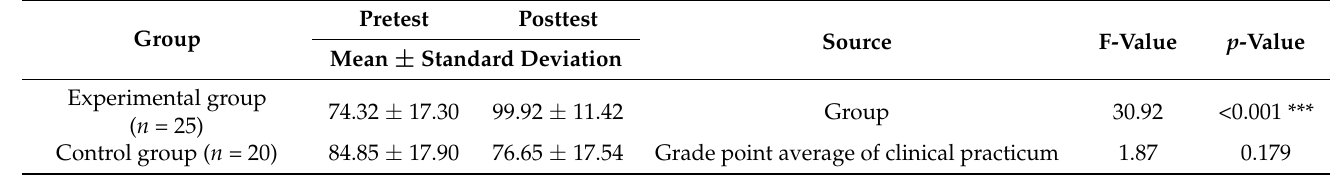
Table 5. Analysis of covariance of problem-solving process between experimental and control groups ( n = 45). Pretest Posttest Group Source F-Value p -Value Mean ± Standard Deviation Experimental group 74.32 ± 17.30 99.92 ± 11.42 Group 30.92 <0.001 *** ( n = 25) Control group ( n = 20) 84.85 ± 17.90 76.65 ± 17.54 Grade point average of clinical practicum 1.87 0.179